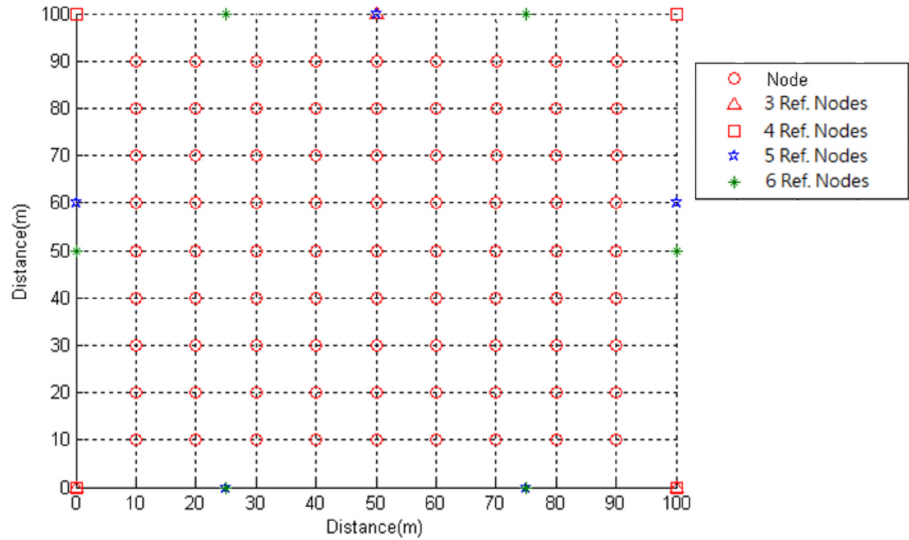
Figure 10. Three, four, five, and six reference nodes for a large range. In Figure 12, the random selection of reference nodes ( σ = 3) is added to a small range. The random selection of three reference nodes ( σ = 3) is higher than the fixed three ( σ = 4) MSEs. Because three random reference nodes may be selected as reference nodes that are very close to each other and will increase the MSE. When there are four at random, the MSE will be a little bit higher than the fixed three ( σ = 3) because the original three reference nodes are very close and the MSE will be very high. If one more reference node supports positioning, the MSE will be lower than the original three reference